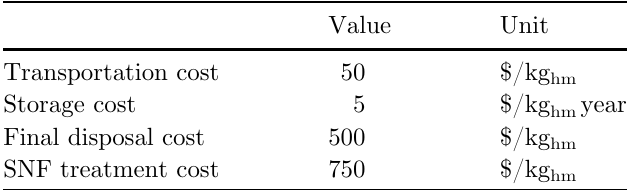
Table 3. SNF backend costs